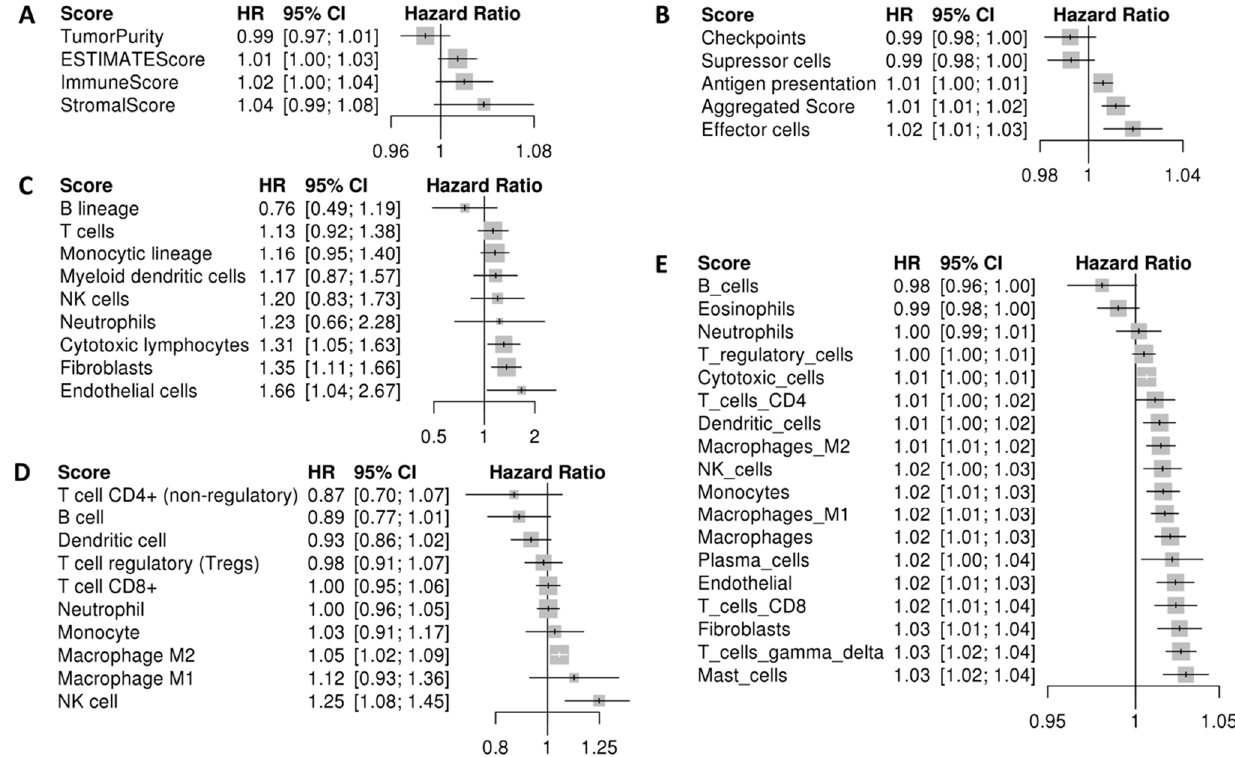
Figure 1. Forest plot showing survival pool analysis using immune and stromal infiltration scores. Horizontal bars indicate the 95% confidence intervals (CI) of the hazard ratio (HR). Each score was evaluated individually and ordered based on the summary effect. Univariate Cox HR analysis were performed using the disease-free survival time. ( A ) HR based on the ESTIMATE scores. ( B ) HR based on the Immunophenoscore individual scores and Aggregated score. ( C ) HR based on immune cell infiltrate scores from MCP-counter. ( D ) HR based on the immune infiltrates from Quantiseq analysis. ( E ) HR based on markers of immune infiltrates from Consensus TME .